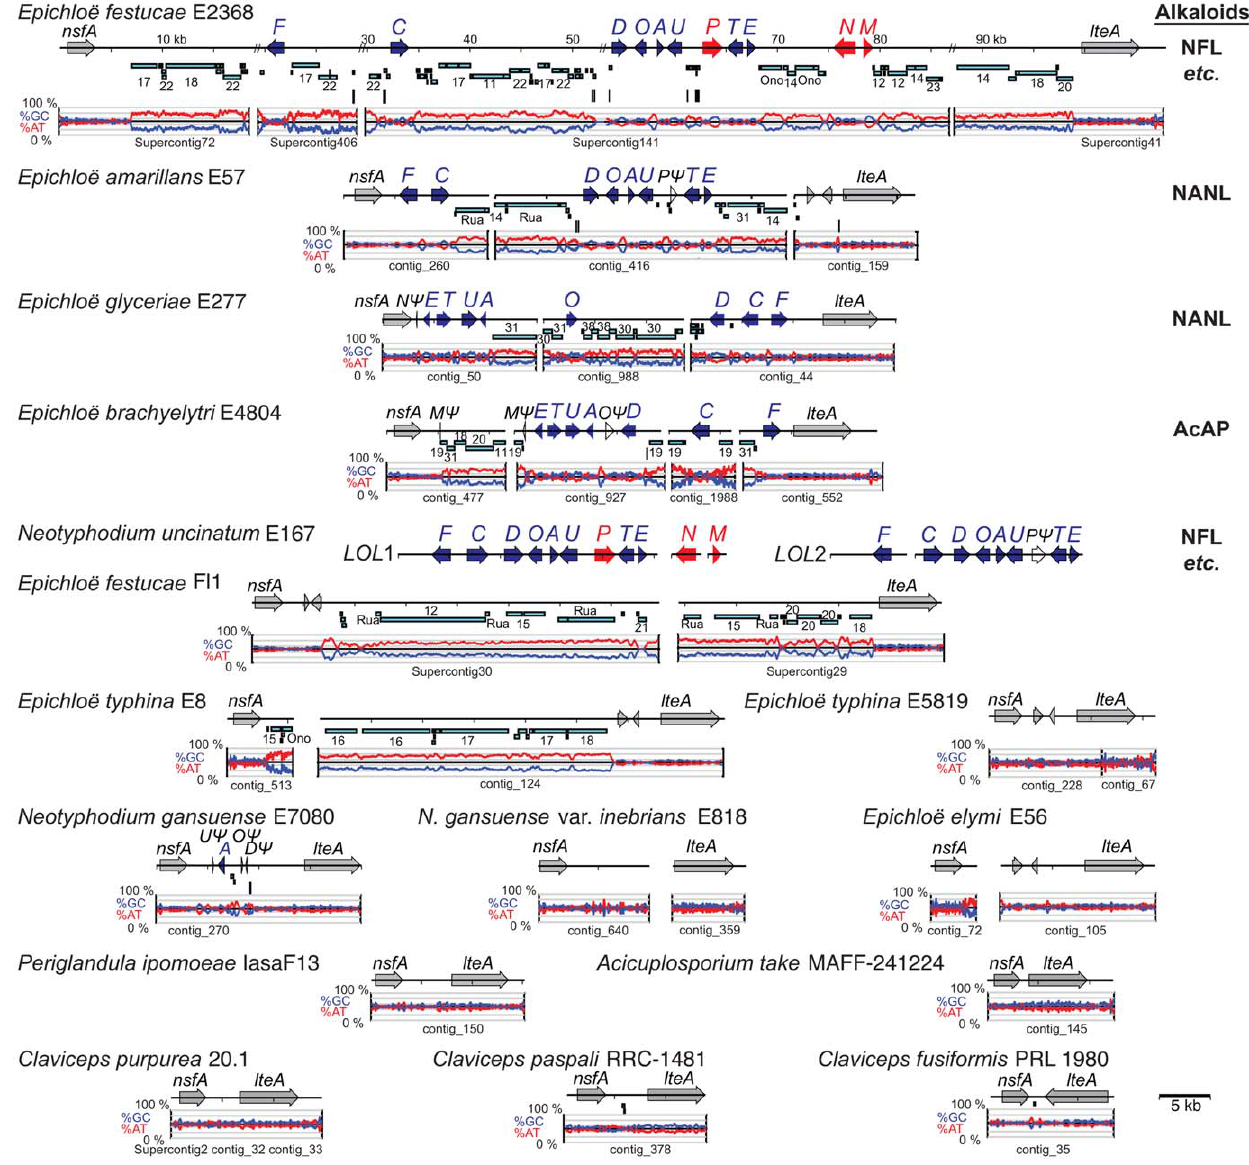
Figure 9. Loline alkaloid biosynthesis loci ( LOL ) in epichloae and the homologous loci in other Clavicipitaceae. LOL genes are indicated by single letters, whereby F=lolF , C=lolC , and so forth. Features are indicated as in Figure 7. Double-slash marks (//) indicate sequence gaps within scaffolds of the assembled E. festucae E2368 genome sequence. Genes for the first fully cyclized intermediate, NANL, are indicated in blue, and those for subsequent chemical decorations are shown in red. The major pathway end-product for each strain is listed at the right of its map, abbreviated as indicated in Figure 4, and in bold for those confirmed in this study.